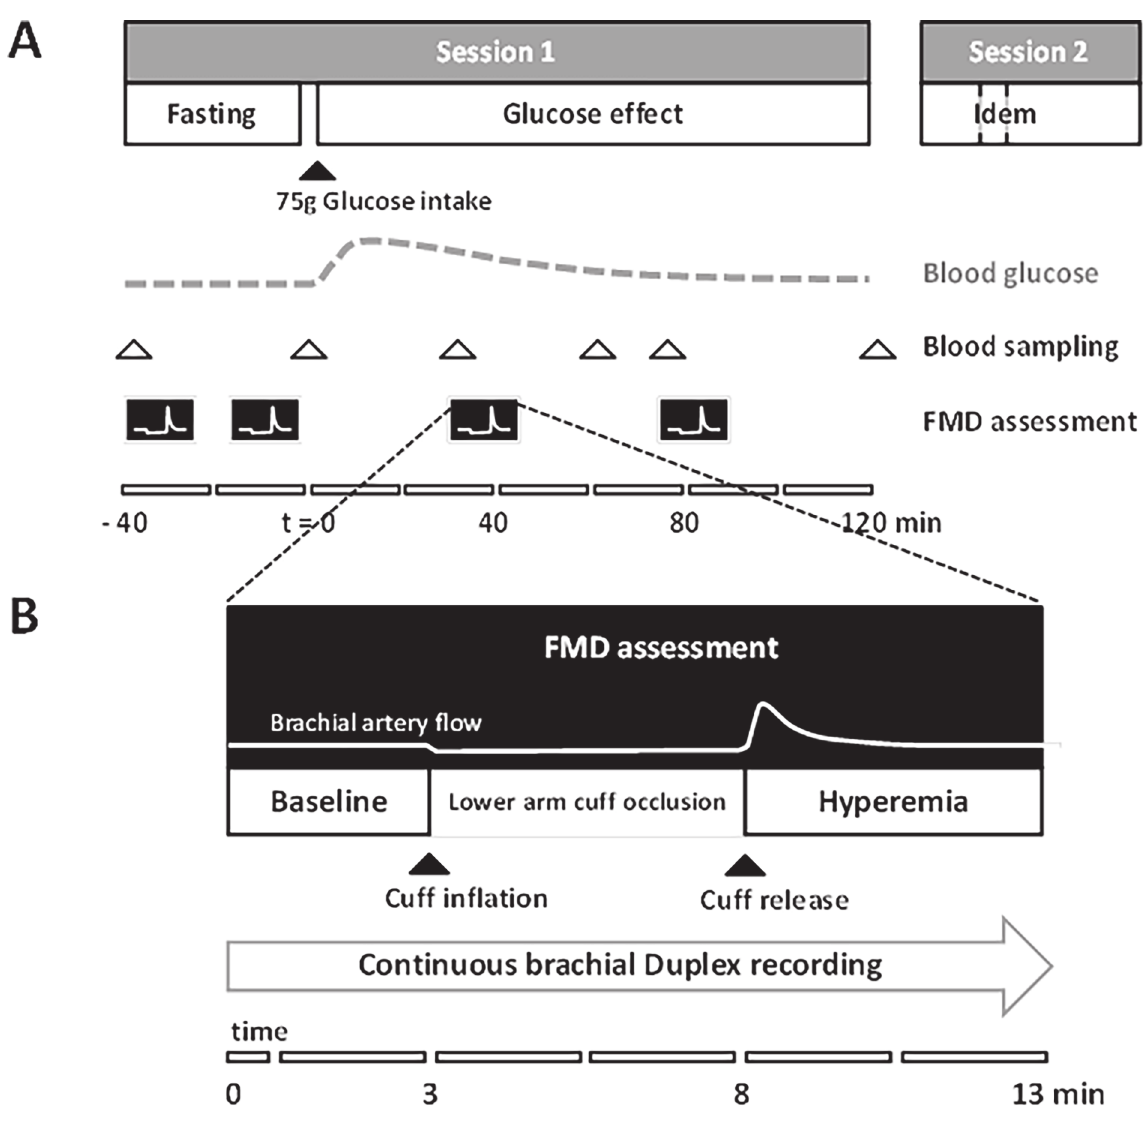
Figure 2. Detailed timelines of (A) the study protocol and (B) the flow-mediated dilation assessment. (A) The effect on brachial artery flow-mediated dilation after glucose loading was assessed repeatedly, sessions 1 and 2 about one week apart. (B) A 5-minute lower arm cuff-occlusion was used to elicit a hyperemic response to measure flow-mediated dilation from a continuous brachial Duplex ultrasound recording (B-mode and pulsed Doppler). Note the stimulus-response type of assessments for both (A) and (B) and the correspondingly different